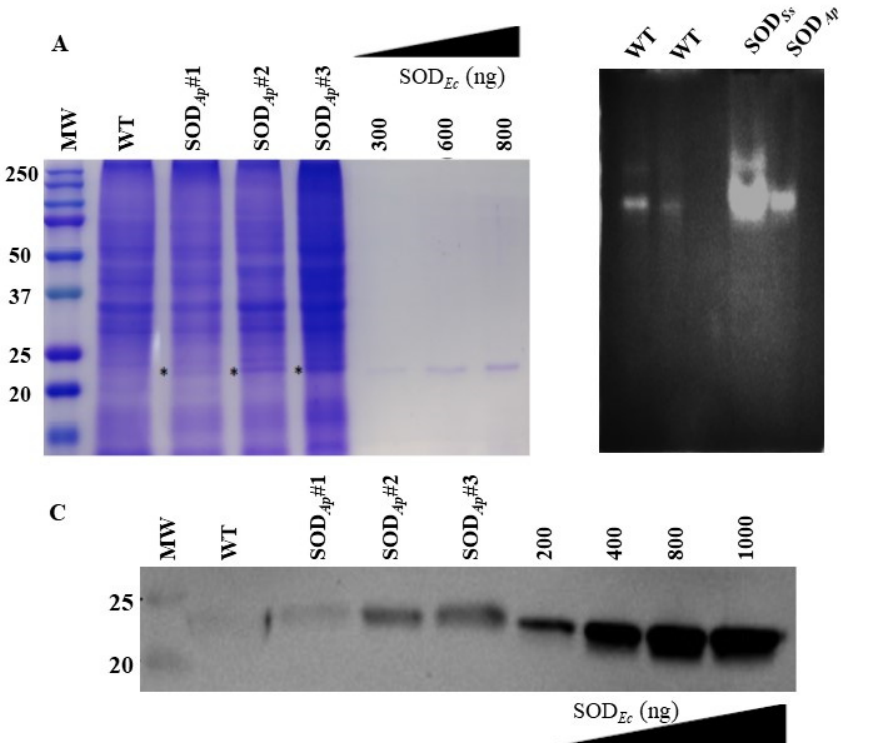
Figure 2. SDS-PAGE, NBT-PAGE and Western blot analyses of total protein extracts from transgenic tomato cell lines. ( A ) Total protein extracts (30 µ g) were electrophoresed on 12% SDS-polyacrylamide gel and detected with Coomassie blue staining. ( B ) Total protein extracts from tomato cell lines untransformed (WT) (first lane: 15 µ g and second lane: 7 µ g) or transformed with sod Ss and sod Ap genes (15 µ g) were electrophoresed on Native-PAGE (10%). Following Native-PAGE, protein bands were detected by in-gel SOD activity staining using the Riboflavin-NBT assay. The results are representative of three independent experiments on three different protein extracts. ( C ) Total proteins (15 μ g) were extracted from the tomato cell lines, separated by SDS-PAGE and transferred to PVDF membrane. WB analysis was carried out using anti-SOD antibody. WT: untransformed tomato cells; SOD Ap #1, SOD Ap #2 and SOD Ap #3: callus lines transformed with sod Ap gene. SOD Ec : commercially available SOD from E. coli was used for the comparative quantification of the relative intensity of band of interest indicated with * in ( A ).